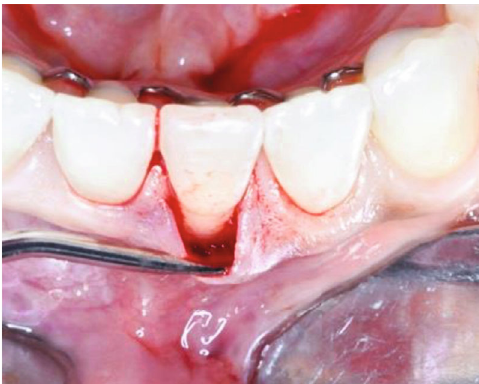
Figure 5: The tunnel patch created to receive the connective tissue